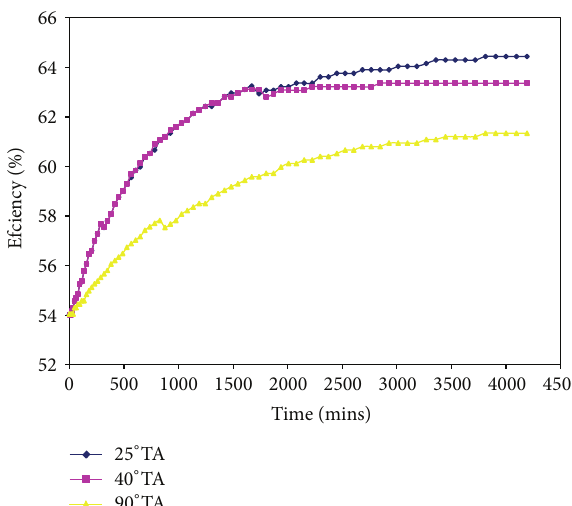
Figure 7: The impact of throat angle on conversion efficiency.